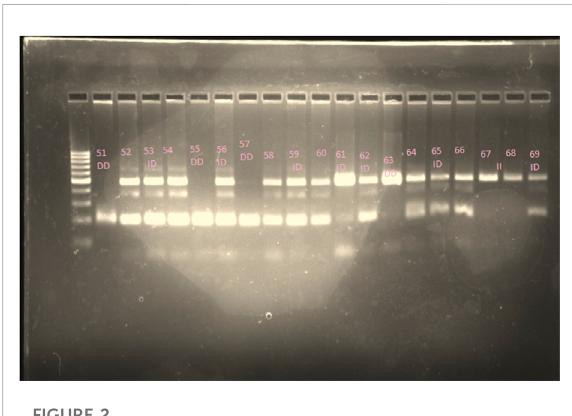
FIGURE 2 Gel electrophoresis showing genotypes of 19 patients. In this study 120 patients were genotyped and 24, 82, and 14 patients were identi fi ed with DD, ID, and II genotypes respectively.